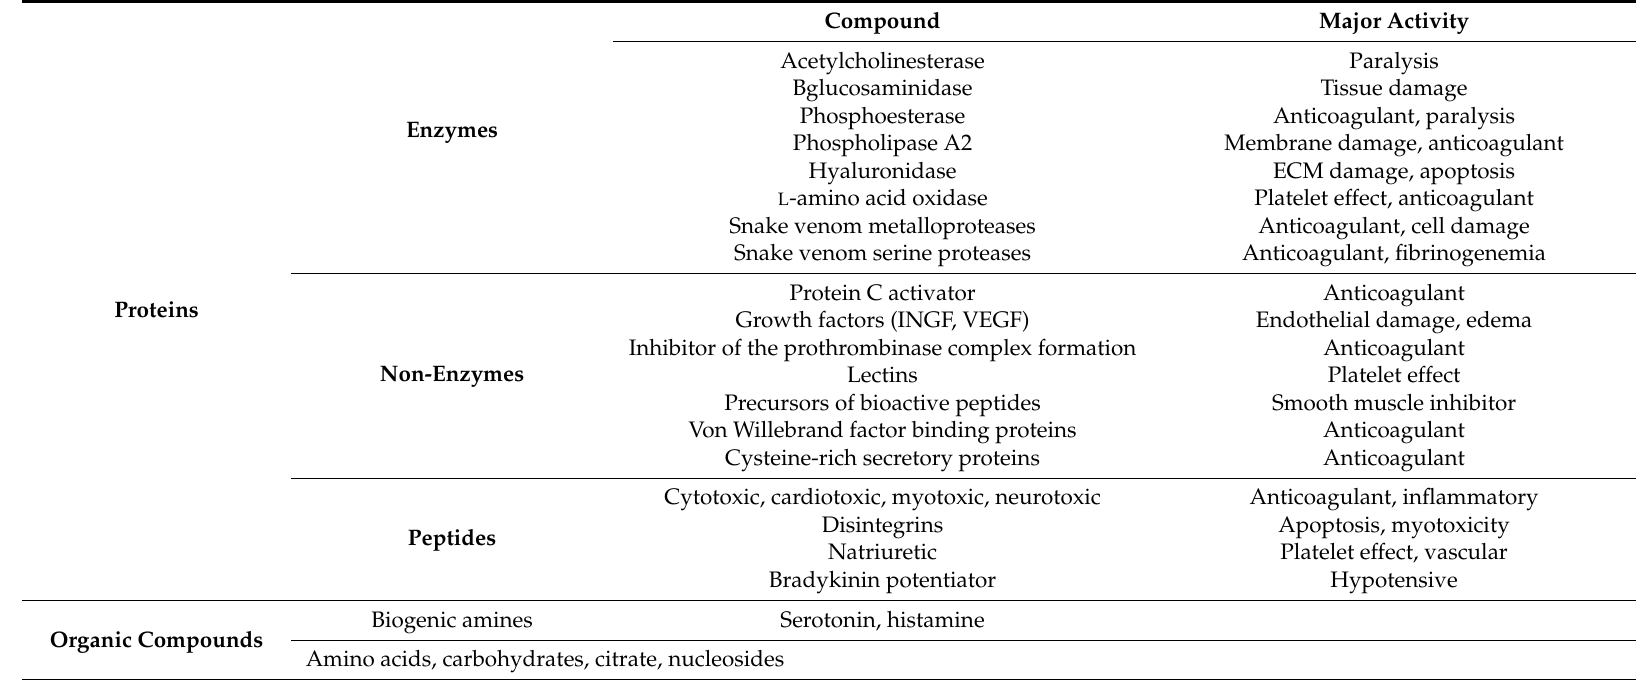
Table 2. Snake venom components and properties (adapted from Koh [74] and Fatima